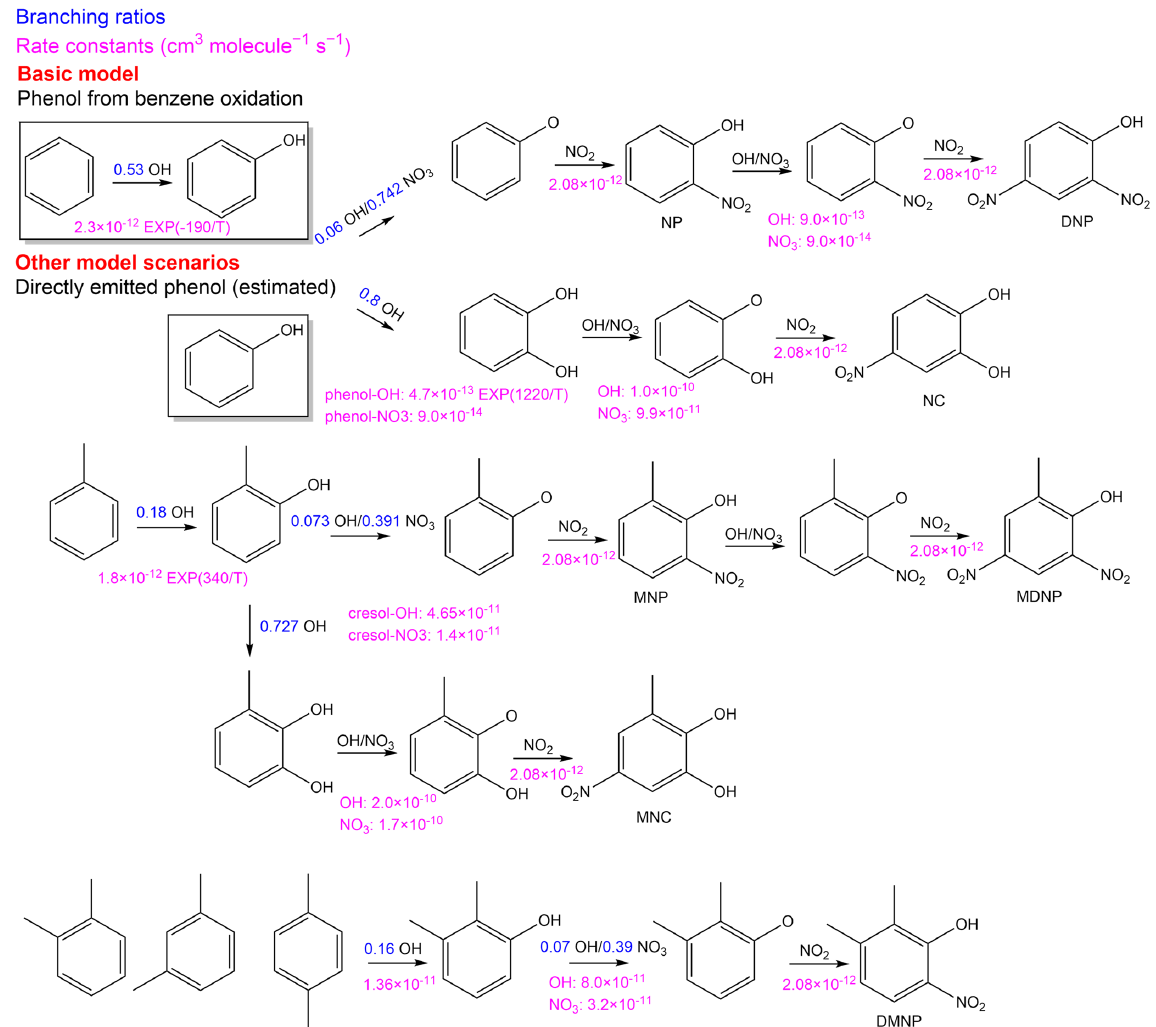
Figure 1. Mechanism related to the secondary formation of the nitrated phenols (NPs) in MCM 3.3.1 applied in this study. Different model scenarios differed in the constraints of the precursors. The basic model constrained the concentration of benzene by measurement from an online GC-MS/FID. The other model scenarios constrained primary phenol concentration rather than benzene estimated by the ratio of phenol / NO y or phenol / CO from fresh vehicle